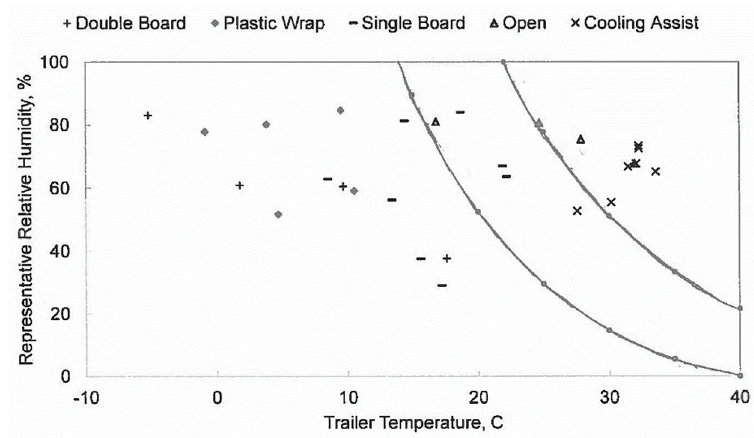
Figure 6. Average representative relative humidity vs. average trailer temperature of 28 monitored trips moving broilers to processing plants. The AET values corresponding to 40 and 65 °C [17] were overlaid.